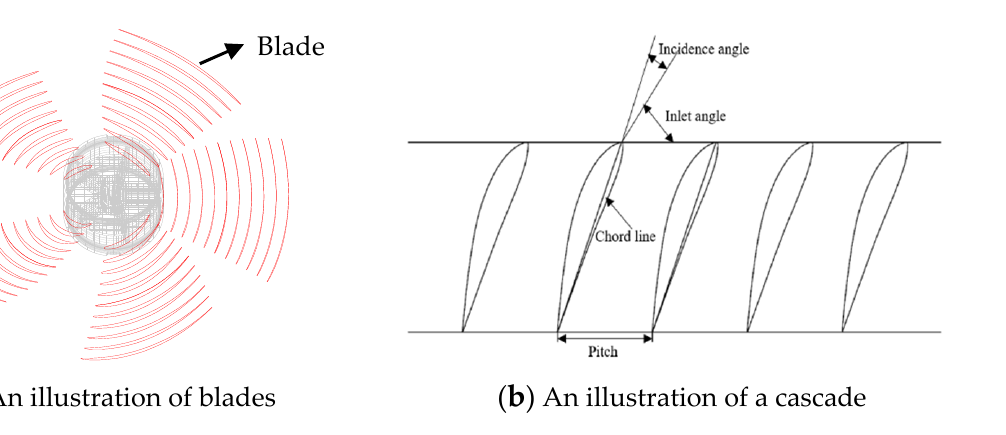
Figure 1. An explanation of blades and a cascade.